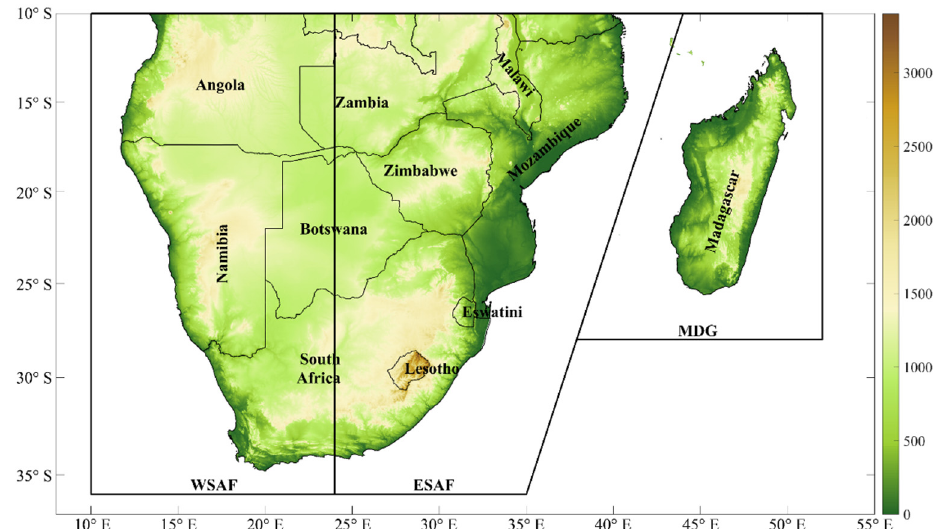
Figure 1. Study area, showing the elevation (m) and the boundaries of the countries in the region. The black lines delineate the WSAF, ESAF and MDG regions in line with the latest IPCC regional demarcations [32]. The surface elevation data are from ETOPO2 [46].